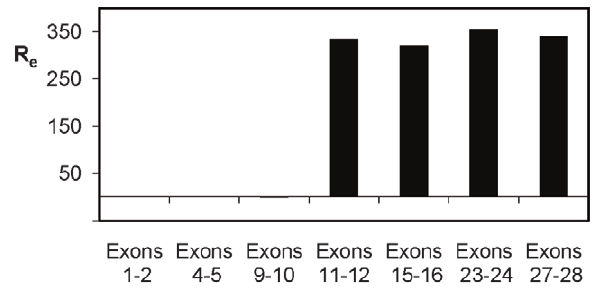
Figure 3. RT-Q-PCR analysis of the expression along the EGFR gene in tumour 26. For each pair, the forward and reverse primers were localised in consecutive exons in order to prevent amplification of DNA traces present in the mRNA preparations. The expression ratio (R e ) was calculated by dividing the normalised expression measured in the tumour by the mean of the normalised expressions measured in the reference set of tumours. Exons 1 to 10 were not over-expressed, indicating that only the truncated form of the gene coded by